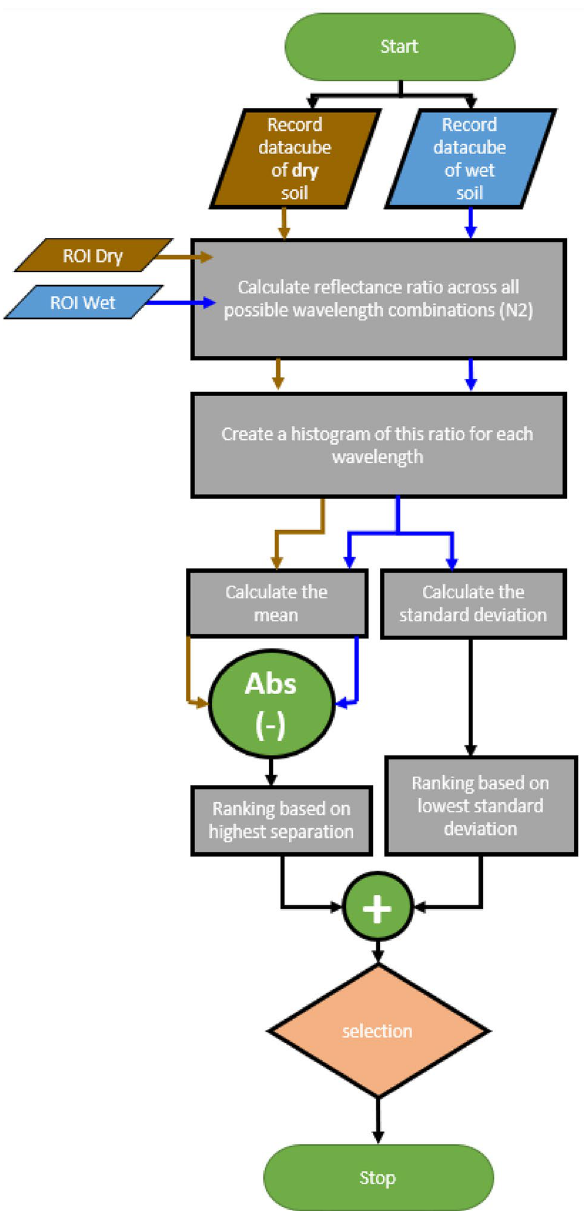
Figure 3. Flow chart describing the hyperspectral image analysis method (HIAM).